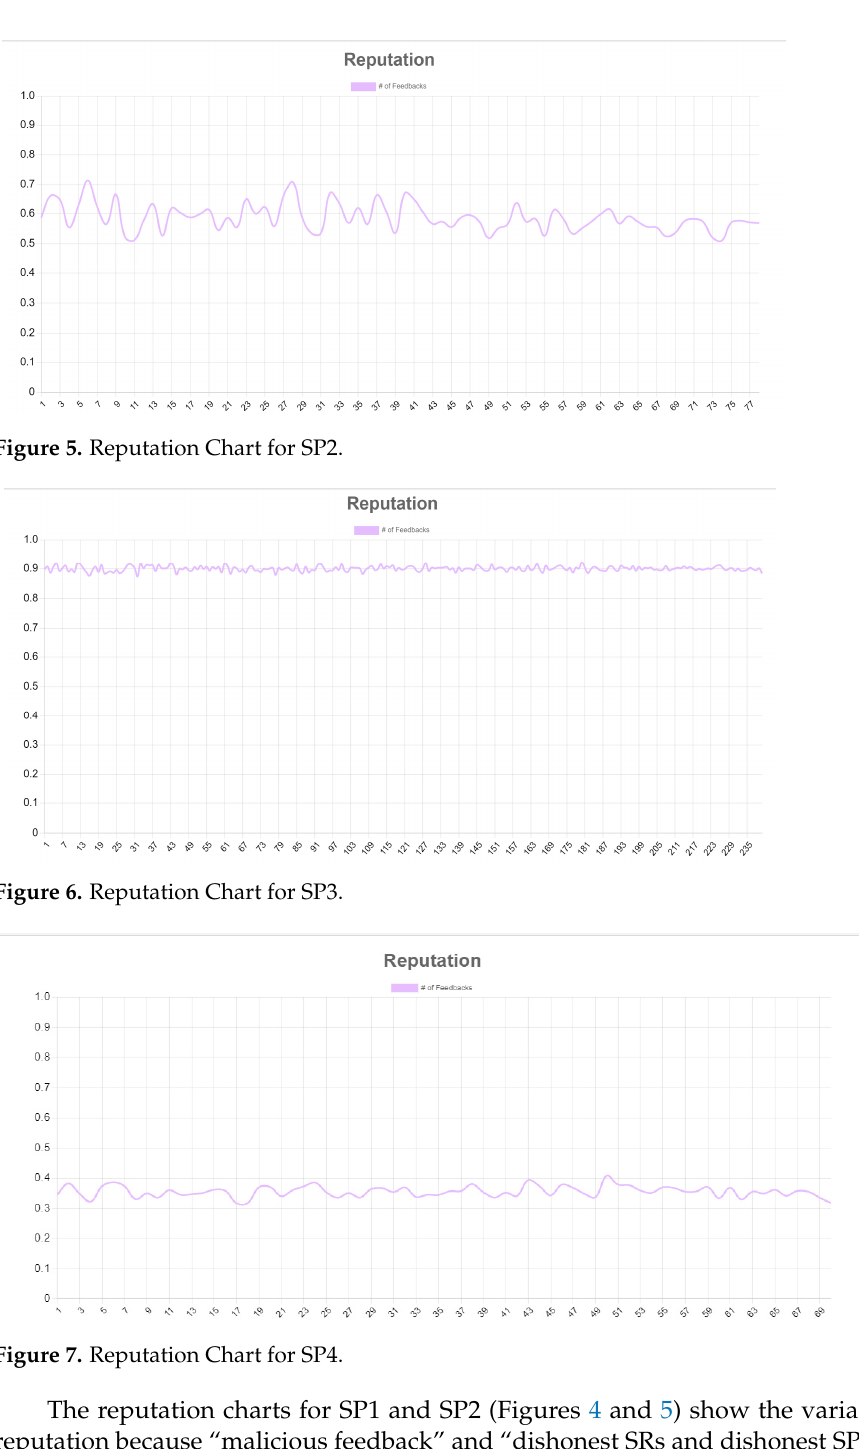
Table 3. Reputation Values representing variation in SP1 status.